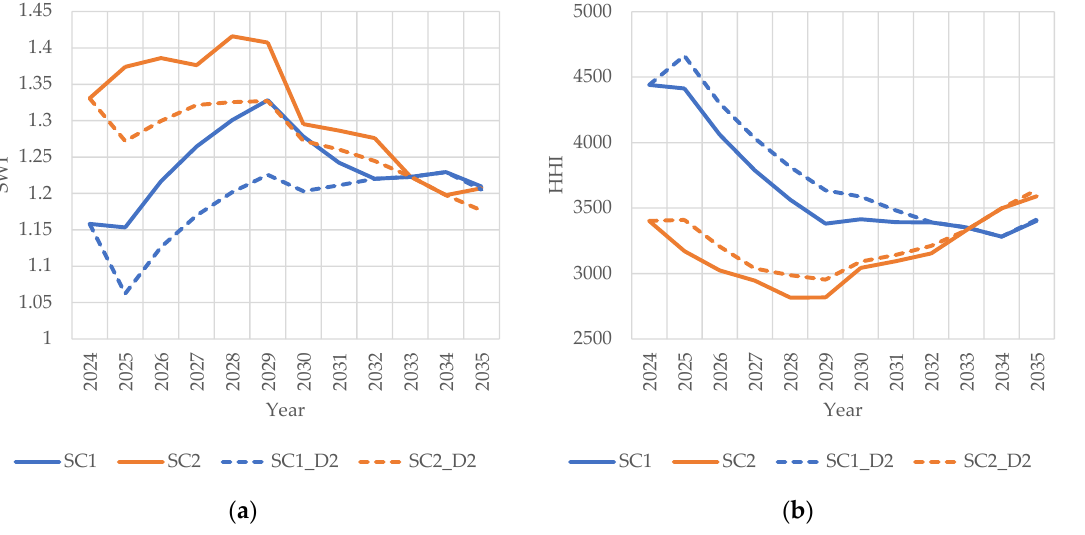
Figure 6. Diversity indicators in the case of the loss of natural gas supply: ( a ) SWI; ( b ) HHI. During the shock phase, less diversification is observed due to the loss of one energy production technology in electricity production. SC2 performs better (SWI higher, HHI lower) in terms of diversity at the beginning of the analyzed period in comparison with SC1. Over time, the share of electricity imports is decreasing, which results in better per- formance of the diversification indicators; however, the share of wind PP is increasing and comprises a large portion at the end of the period, which results in a lower balance of electricity production in SC2 than in SC1.